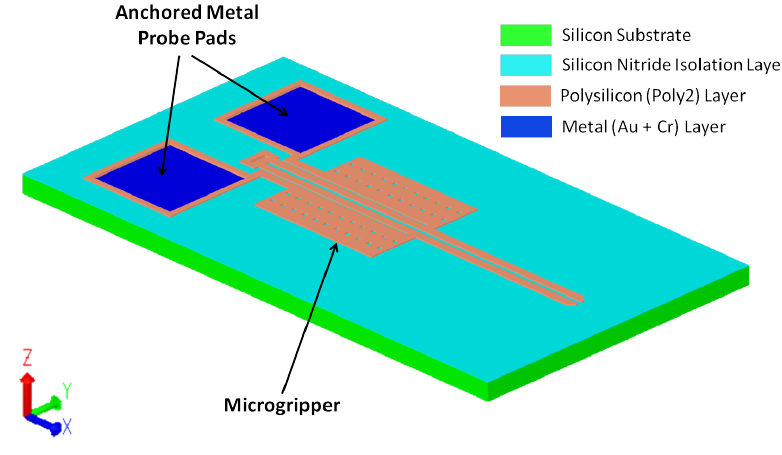
Figure 9. A 3D model of the electrothermal microgripper in Coventorware (cid:114)